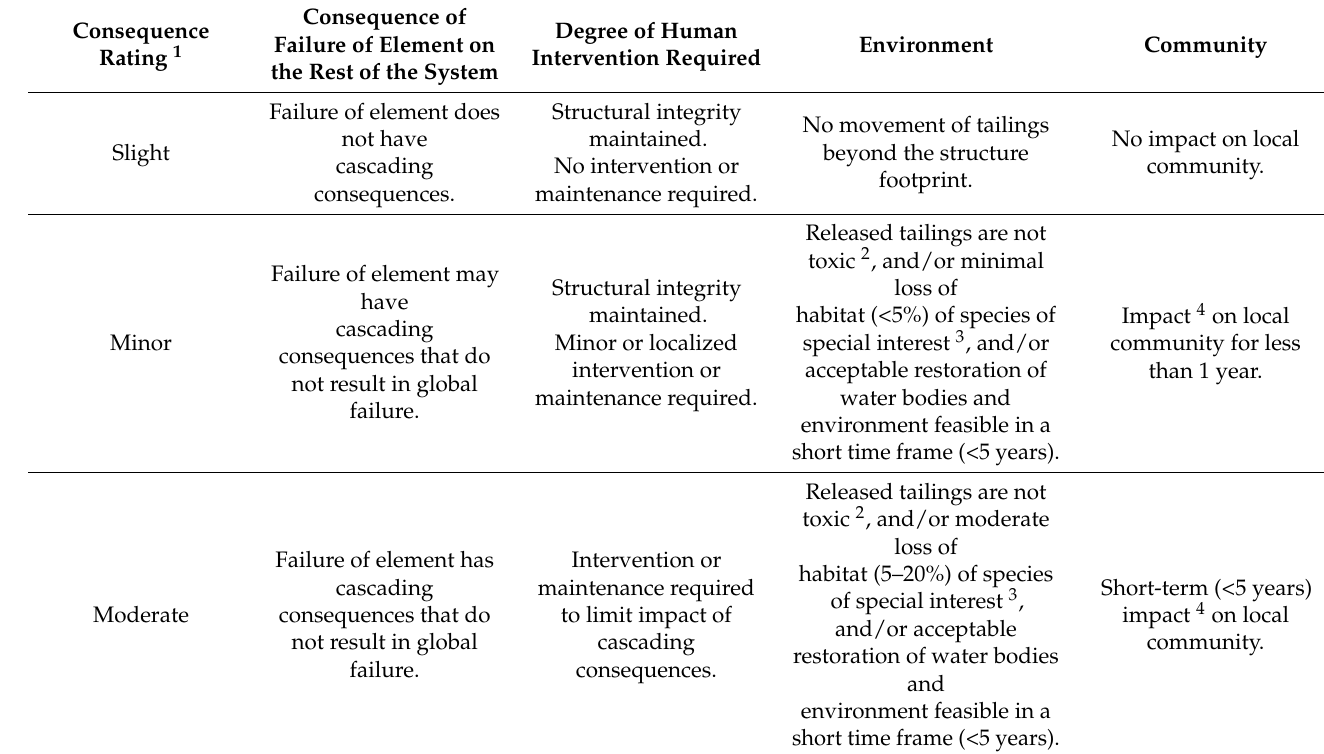
Table 2. Consequence rating (Reprinted from Schafer et al.